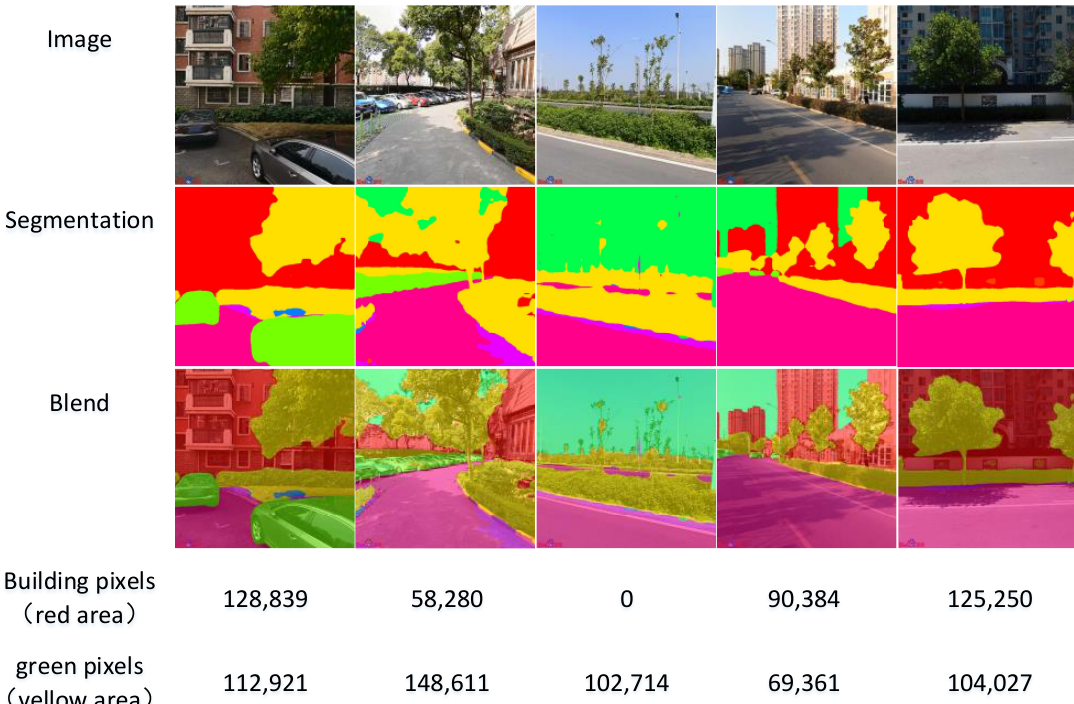
Figure 4. The results of street view image segmentation.